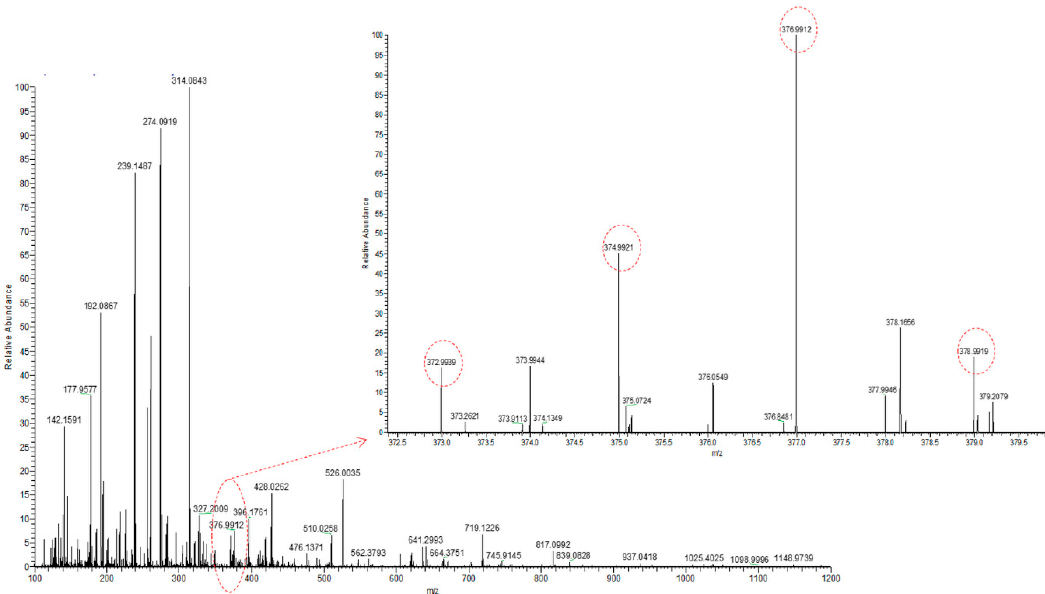
Figure 5. MS spectrum registered for the ion of 2,3-DHP-selenocysteine-cysteine with m/z 376.9912, with isotopic pattern characteristic for selenium compounds.